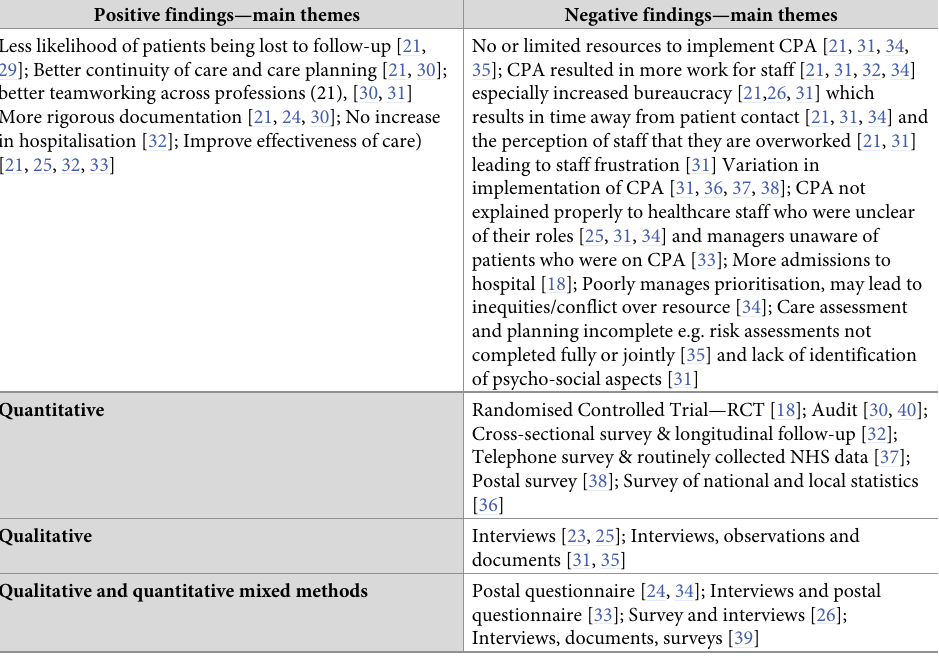
Table 2. Tradition 1: Evaluations of effects of CPA on the organization, management and delivery of